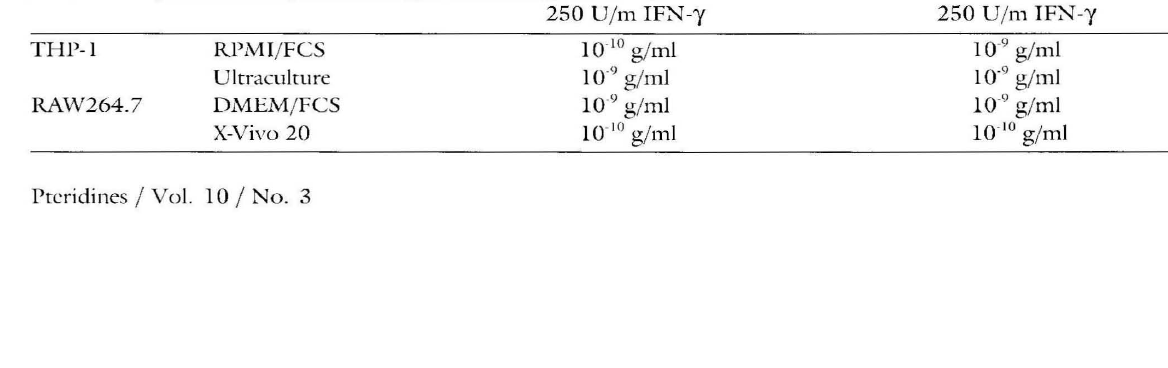
Table 1. Influence of serum and IFN-y-dose on detection limits of LPS from E. coli 055:B5 in THP-l and RAW264.7 cells. Rl~MI 1640 and DMEM are supplemented with 10% heatinactivated FCS (all from Biochrom, Berlin, Germany, low endotoxin quality). Ultraculrure and X-Vivo 20 were purchased from Bio Whittaker